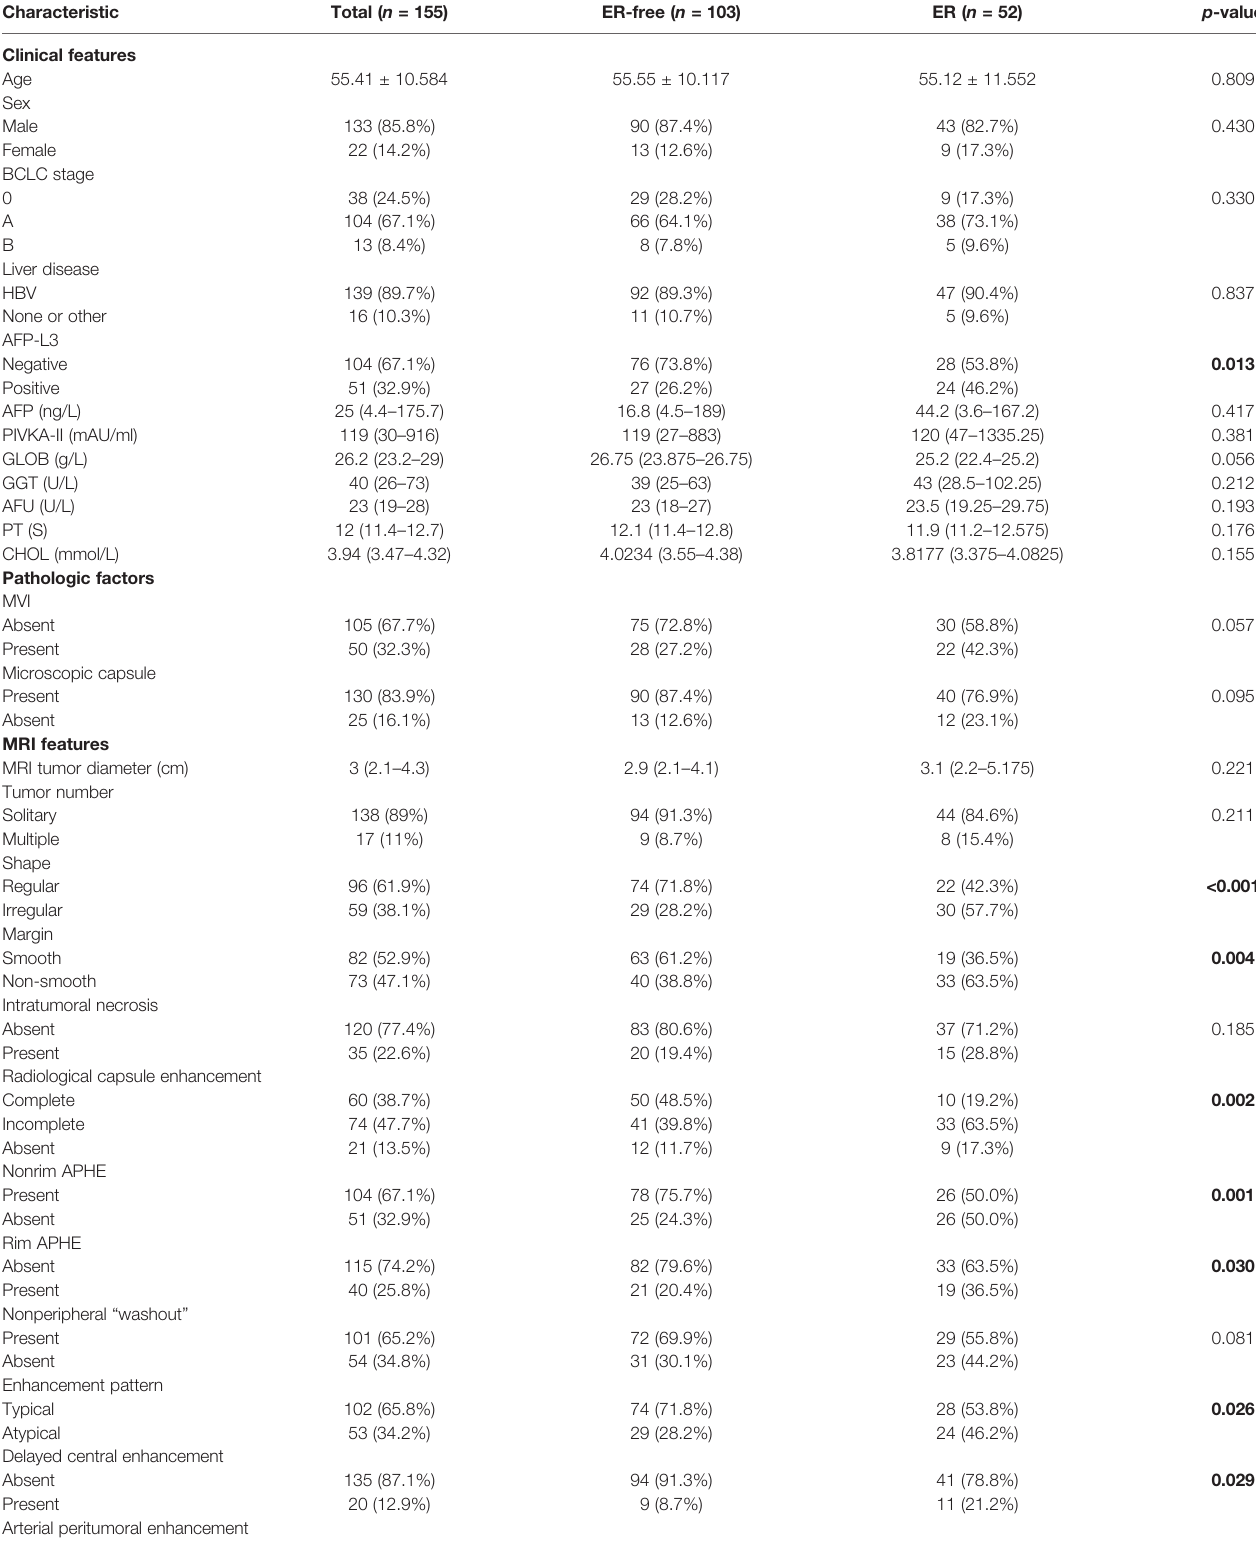
TABLE 1 | Baseline patient